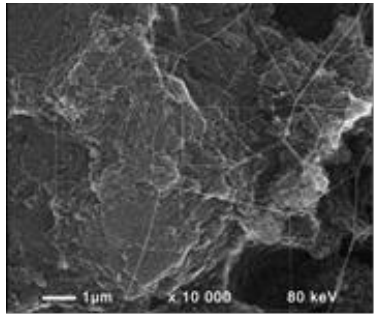
Figure 2. SEM image of zeolite-based GDL with 11 wt.% PTFE.